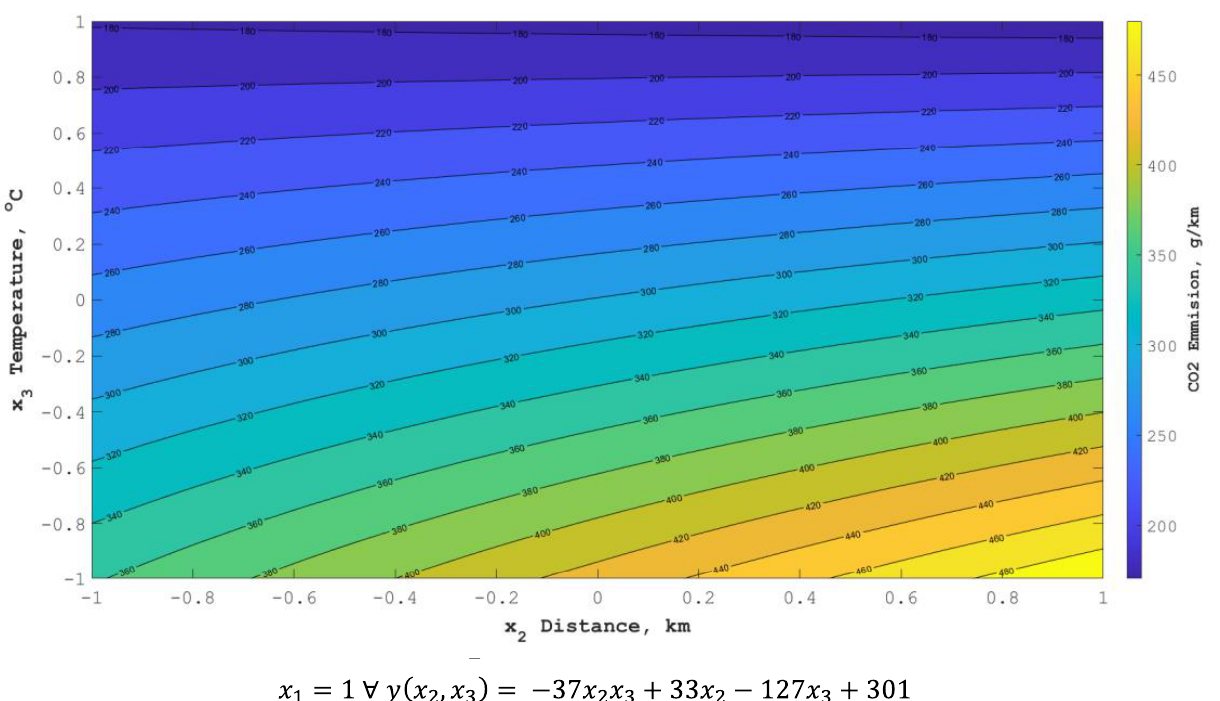
Figure 3. Change in CO 2 emissions depending on the variability of factors x 2 and x 3 for a vehicle (ICE) moving for 20 min (x 1 = 0).